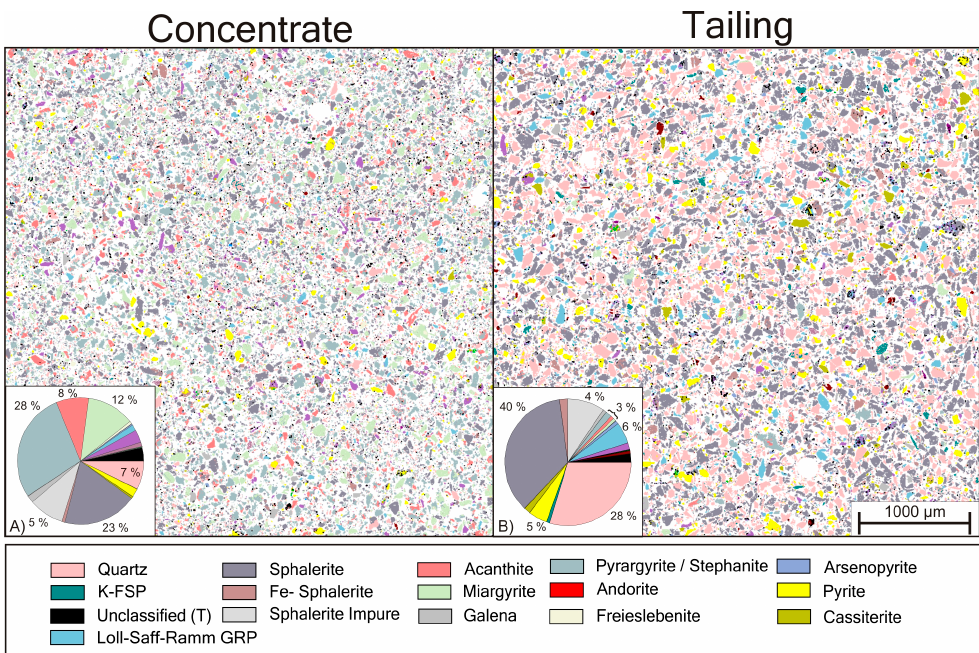
Figure 14. Detailed section view and modal composition (vol. %) of the minerals processing concentrate ( A ) and tailings ( B ). ( A ) and tailings ( B ).